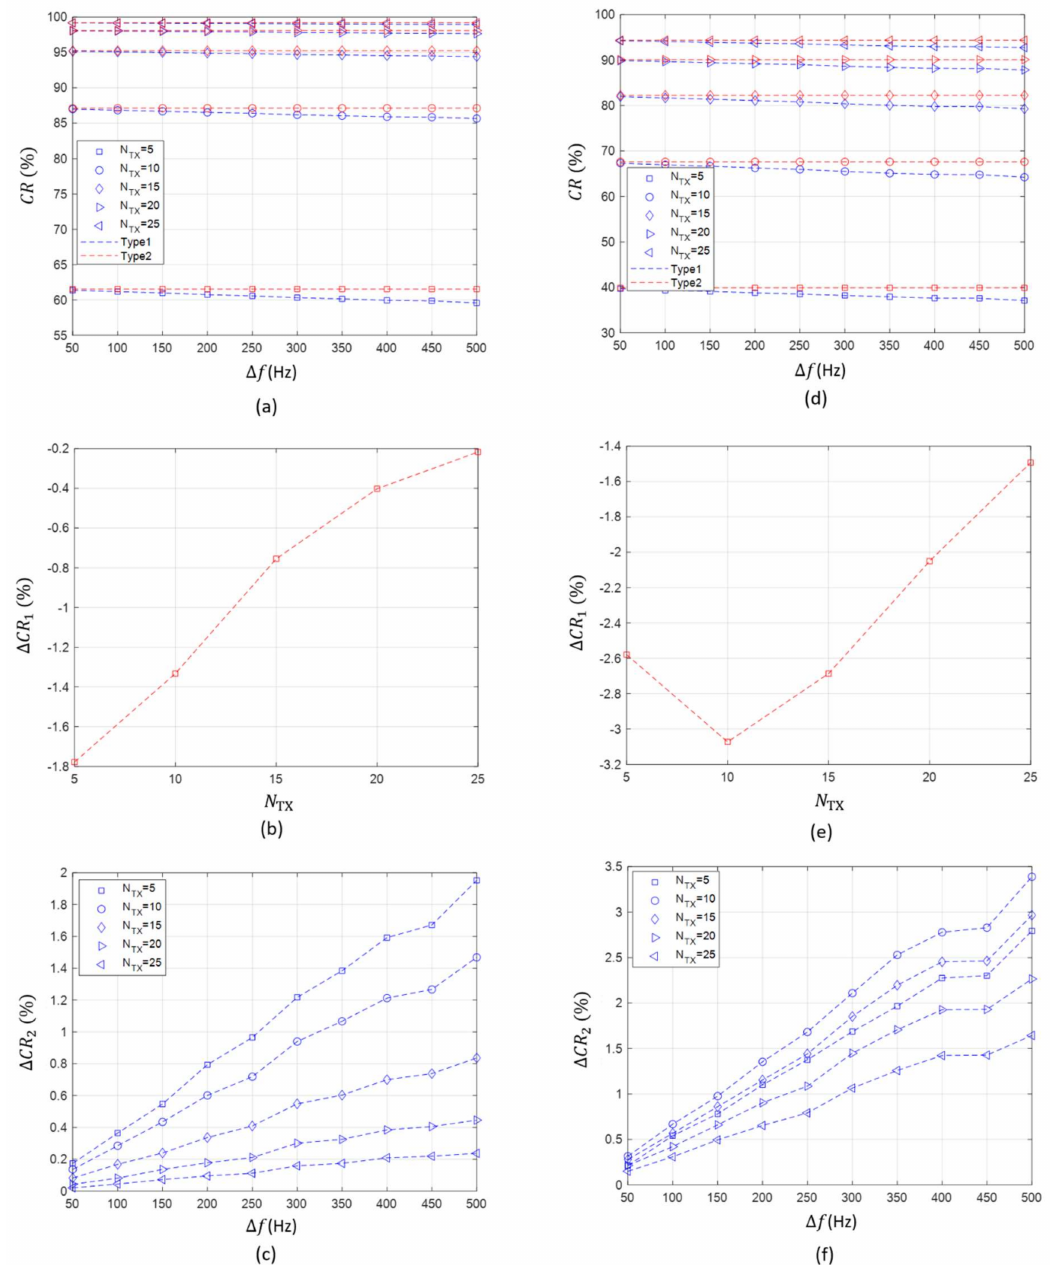
Figure 4. The CR of Type 1 and Type 2 according to ∆ f , N TX , and B MAX . ( a ) CR according to ∆ f , N TX at B MAX = 10 kHz. ( b ) ∆ CR 1 at B MAX = 10 kHz. ( c ) ∆ CR 2 at B MAX = 10 kHz. ( d ) CR according to ∆ f , N TX at B MAX = 5 kHz. ( e ) ∆ CR 1 at B MAX = 5 kHz. ( f ) ∆ CR 2 at B MAX = 5